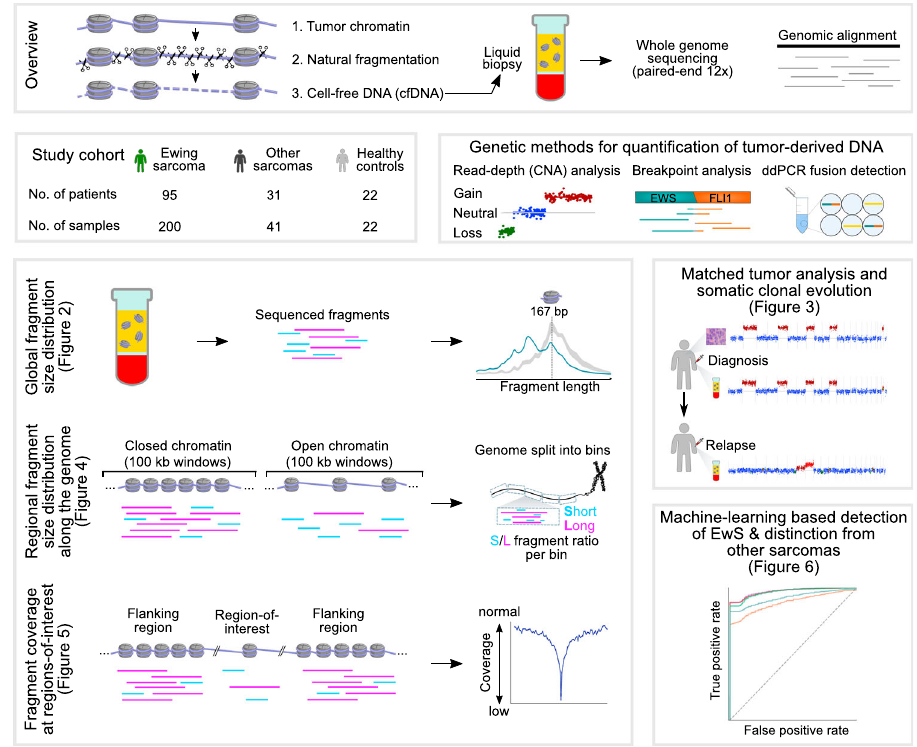
Fig. 1 Whole-genome sequencing of cfDNA enables fragment-based liquid biopsy analysis in Ewing sarcoma. The top row of the fi gure describes the fragmentation and fragment-based analysis of cfDNA in cancer patients. The center row introduces the study cohort (center left) and illustrates the quanti fi cation of tumor-derived DNA based on genetic evidence, which is used as a reference in this study (center right). The bottom part of the fi gure outlines three complementary approaches to fragment-based cfDNA analyses: global fragment-size distribution; regional fragment-size distribution along the genome; and fragment coverage at regions-of-interest (bottom left). CNA pro fi les were used for comparing cfDNA to matched tumors biopsies and for time-resolved monitoring of tumor evolution. Fragment-based cfDNA metrics were combined for machine learning-based tumor detection and classi fi cation (bottom right). The main fi gures describing each of the analyses are indicated in